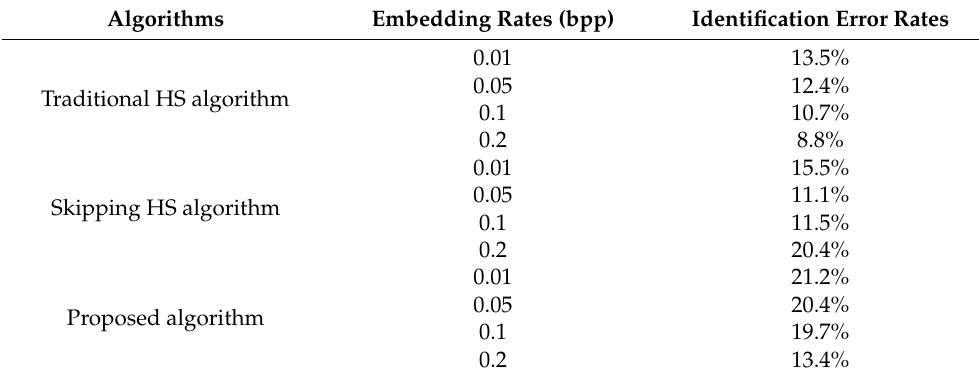
Table 2. Performance of resisting steganalysis for HS